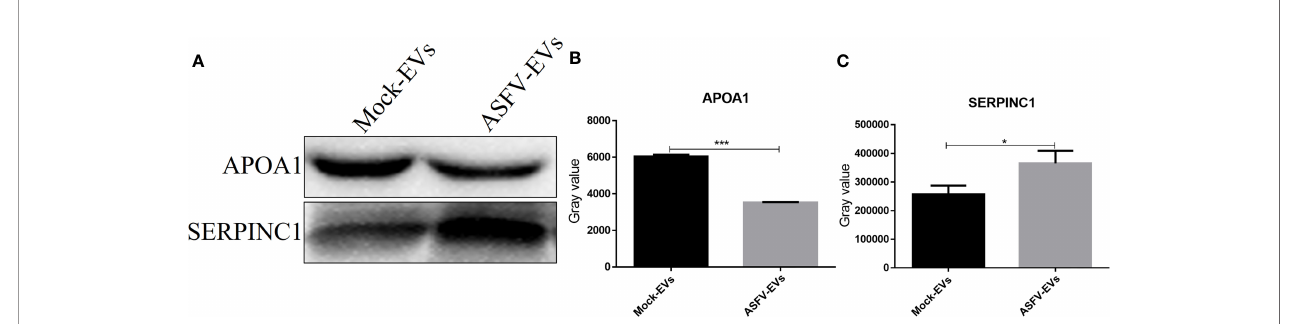
FIGURE 4 | Differentially expressed protein veri fi cation. (A) The protein APOA1, and SERPINCI were veri fi ed by WB analysis. Before the WB experiment, the total protein concentrations of ASFV-EVs and MOCK-EVs were quantitated by measuring the UV absorbance at 280 nm, and the protein concentrations of ASFV-EVs and MOCK- EVs were adjusted to be equivalent. (B) The gray-scale scanning analysis of APOA1 protein in (A) . (C) The gray-scale scanning analysis of SERPINCI protein in (A) . The data were presented as means ± SD (n = 3 for each group). A signi fi cant difference was calculated using two-tailed t-test; * P < 0.05 and *** P <